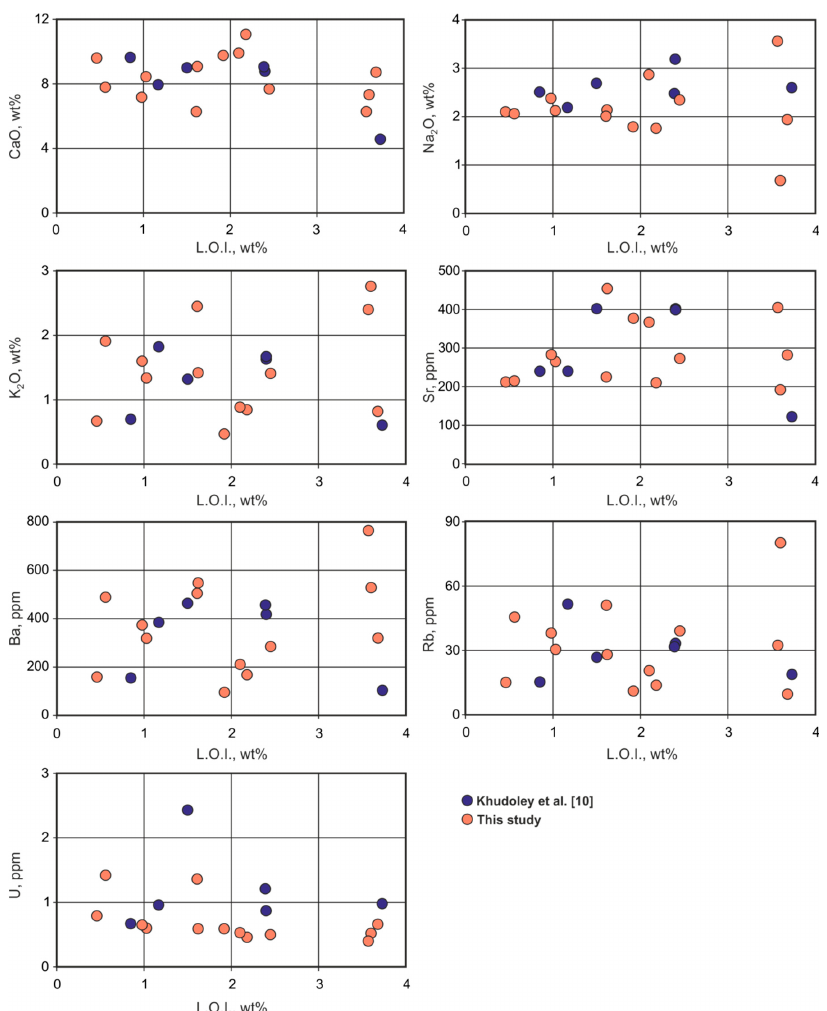
Figure 10. Plots of L.O.I. vs. mobile major and trace elements for the Suordakh event mafic intrusions cutting the Gornostakh Anticline [10] and those cutting Cambrian units, as well (this study), showing no correlation between L.O.I. and the mobile elements concentrations.